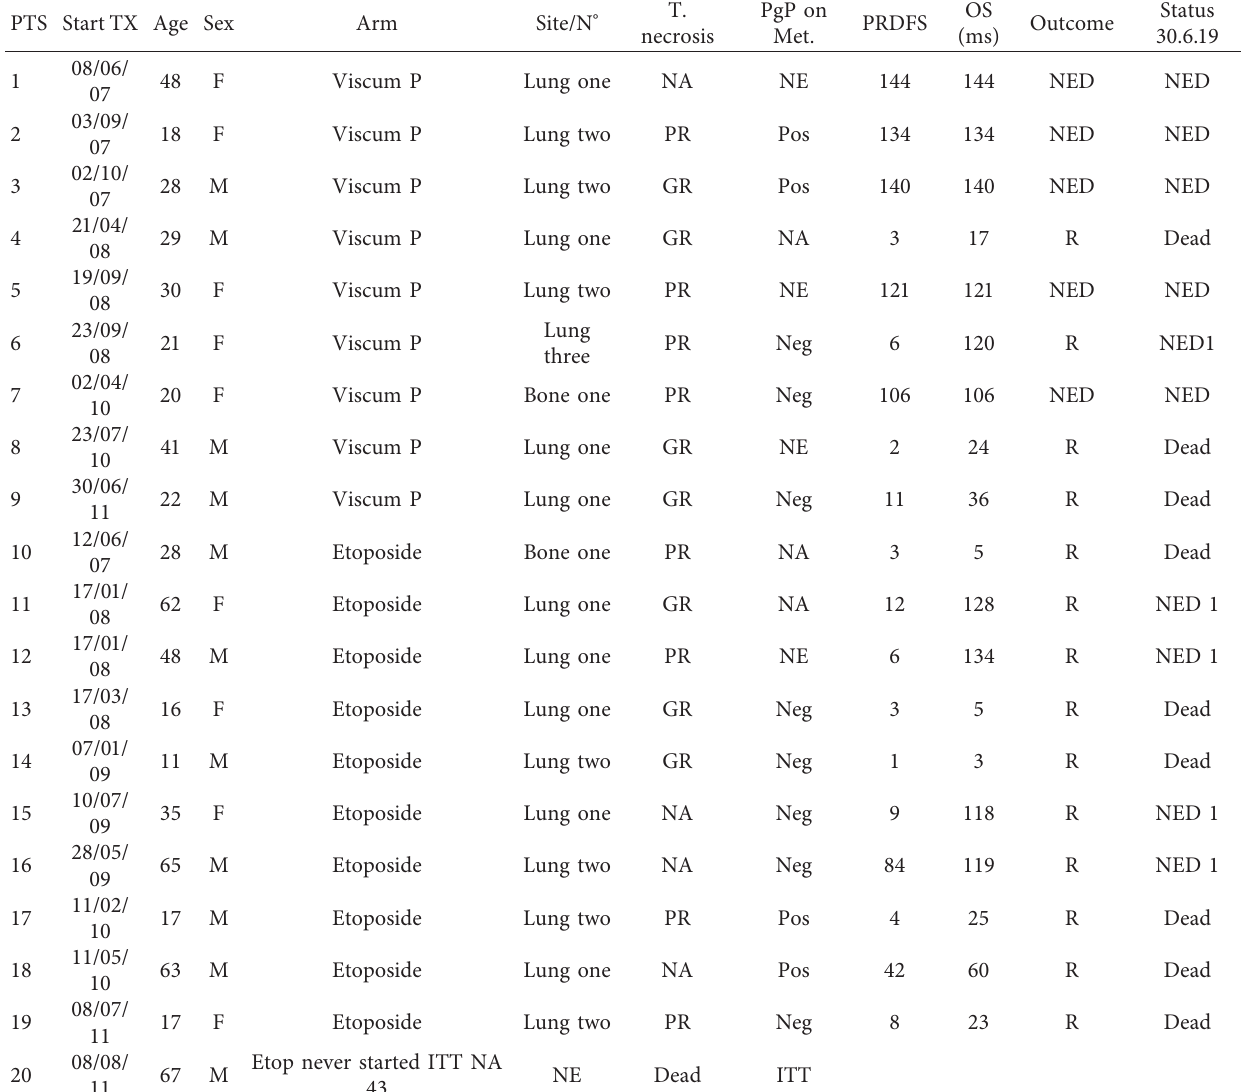
Table 1: Patients